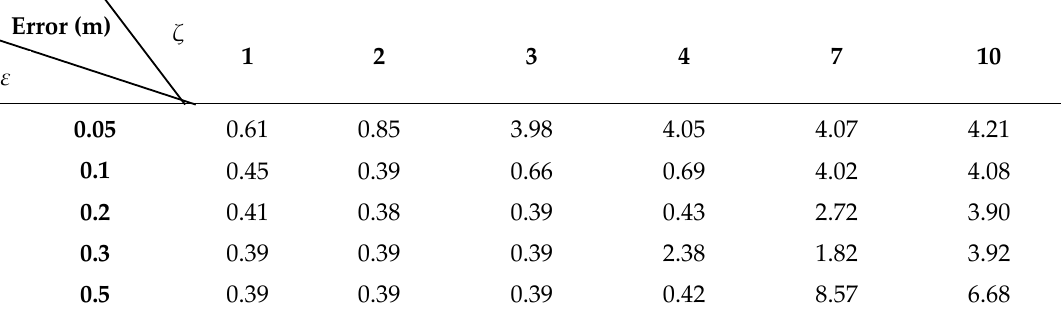
Table 7. E ff ect of ε and ζ on localization accuracy. Table 7. Effect of ε and ζ on localization